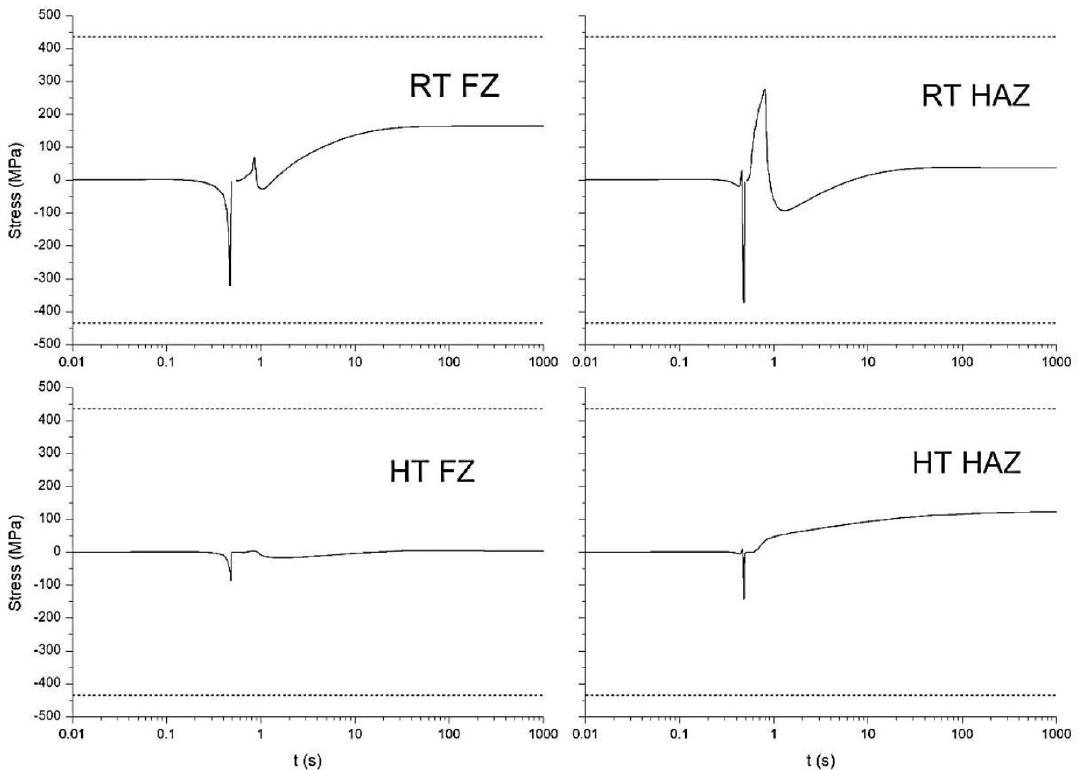
Figure 3. FEA results of the stress as a function of time for room temperature (RT) and high temperature (HT) welds in the fusion zone (FZ) and heat-affected zone